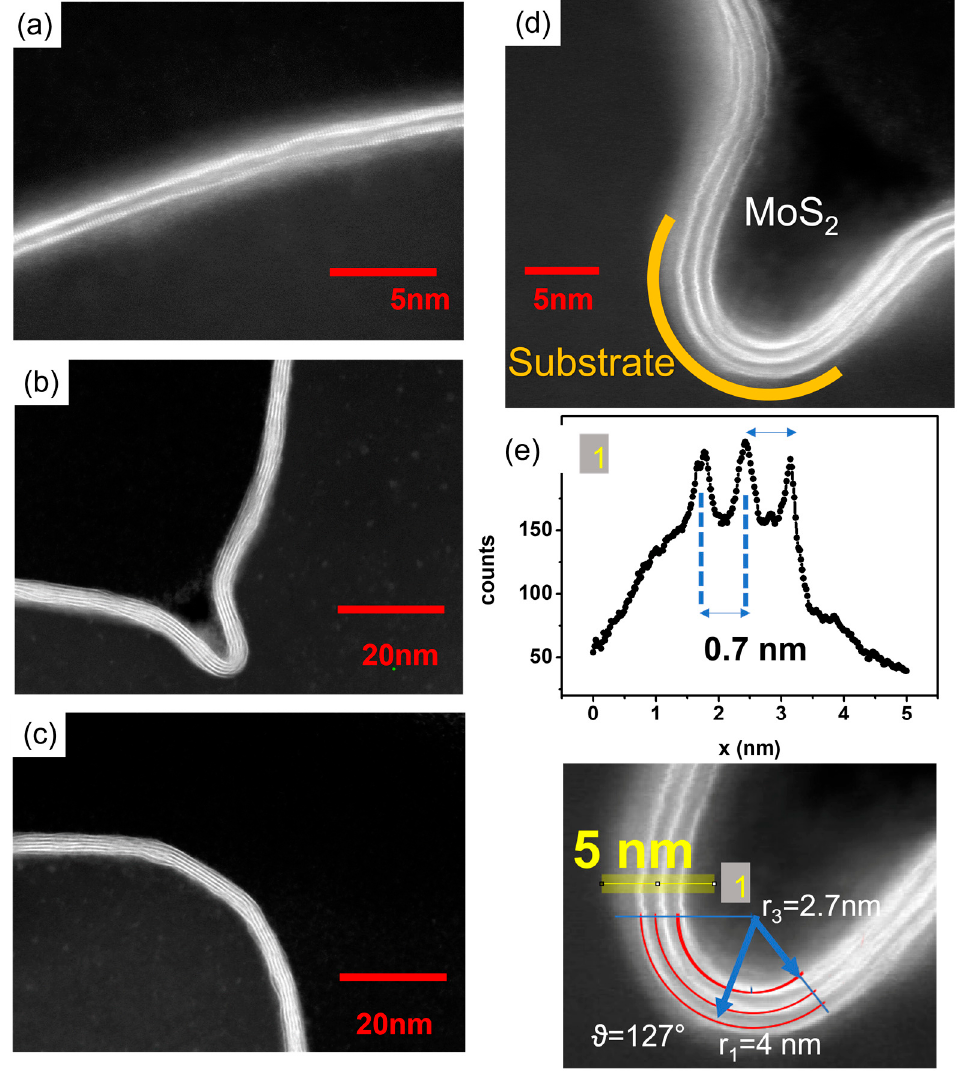
Figure 2. HAADF-STEM images. ( a – d ) cross-sectional HAADF-STEM images showing the MoS 2 layers adapting to the substrate curvature even at the highest values. In HAAD-STEM imaging of the MoS 2 layers, the bright contrast is obtained at the molybdenum atoms due to the higher atomic mass compared to sulphur atoms. ( e ) Intensity line profile along the yellow path (indicated with “1”) in the zoomed-in figure of panel ( d ). The peaks in the plot indicate the position of the molybdenum atoms in the MoS 2